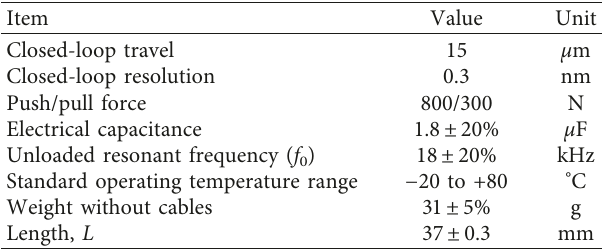
Figure 2: Two specimens sandwiched between the moving clamp and two stationary metal parts. Table 1: Specifications of the chosen stacked preloaded piezo- electric